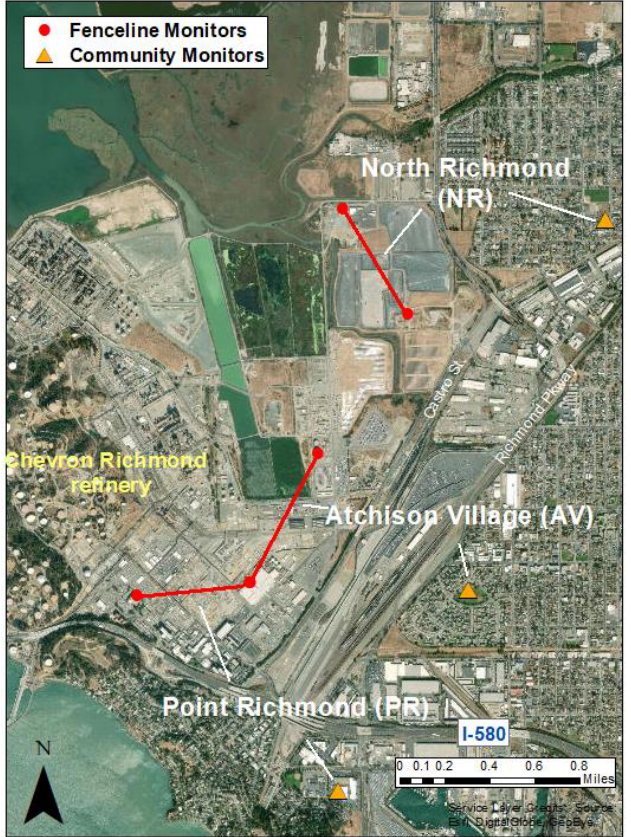
Figure 1. Community and fenceline monitoring network near the Chevron Richmond